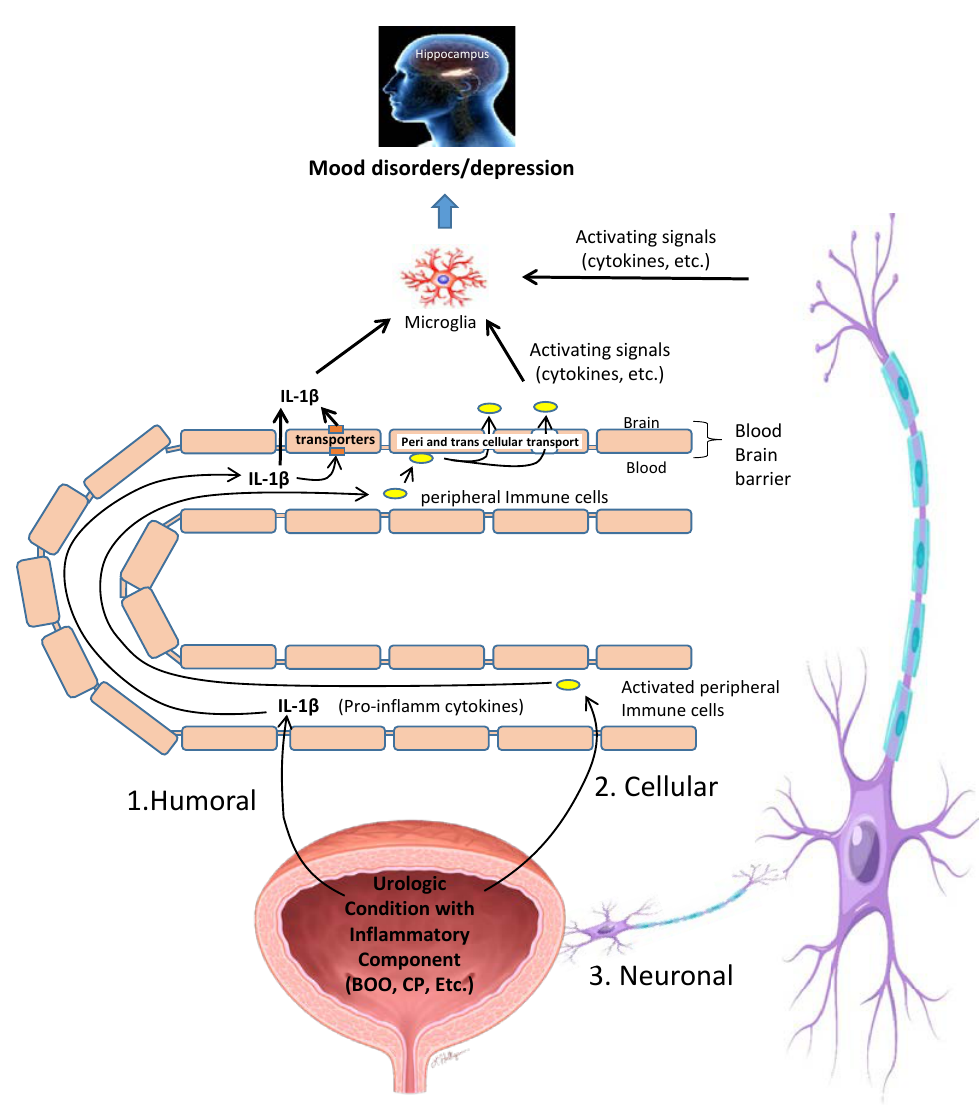
Figure 9. Illustration of possible mechanisms by which inflammation in the bladder caused by a Urinary Condition with an Inflammatory Component (UCIC) is converted into neuroinflammation in the CNS. Depicted are three possible mechanisms that can convey a signal of inflammation into the CNS where its translated into neuroinflammation, perhaps in many areas but most certainly in the hippocampus. 1. The humoral pathway whereby proinflammatory cytokines are released from the bladder and transferred to the brain trough the circulatory system. There they pass through the BBB (either paracellularly or through transporters) and into the brain where they activate microglia (and perhaps astrocytes) to trigger neuroinflammation and mood disorders. 2. The cellular pathway whereby immune cells are activated in the periphery and travel through the circulatory system to the brain where the cross the BBB through extravasation as well as pores in the endothelial cells themselves. Inside the BBB they activate microglia (and perhaps astrocytes), triggering inflamma- tion and mood disorders. 3. The neural pathway whereby activating signals (cytokines, etc.) are carried into the brain through ascending fibers to activate microglia (and perhaps astrocytes) to trigger inflammation and mood disorders. Some image(s) used under license from Shutterstock.com (hippocampus, microglia and